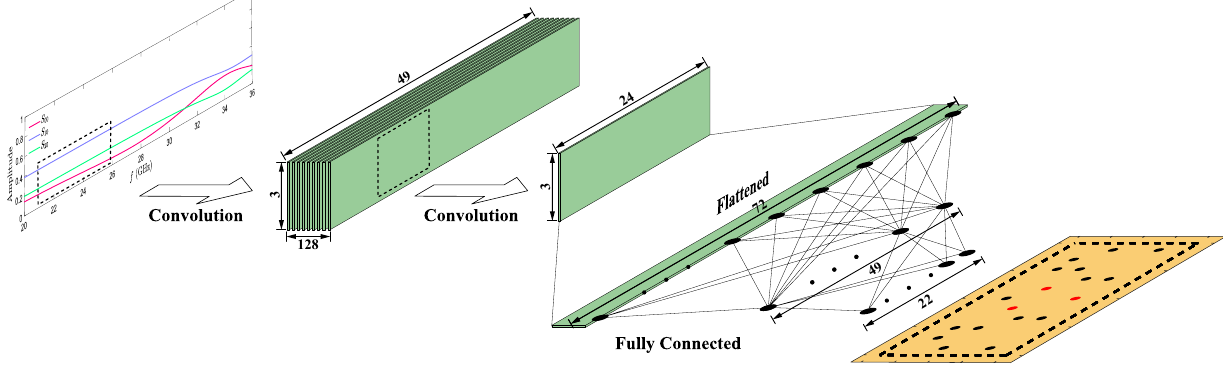
Figure 6. Overview of the DNN inverse design. The scattering parameters of the symmetrical structure are the input of the network. The first convolutional layer has 128 channels with a kernel size of 5 second convolutional layer has one channel with a kernel size of 3 2D-convolutional layers is (2,1). The output of the second convolutional layer is 24 as the fully connected layers’ input.